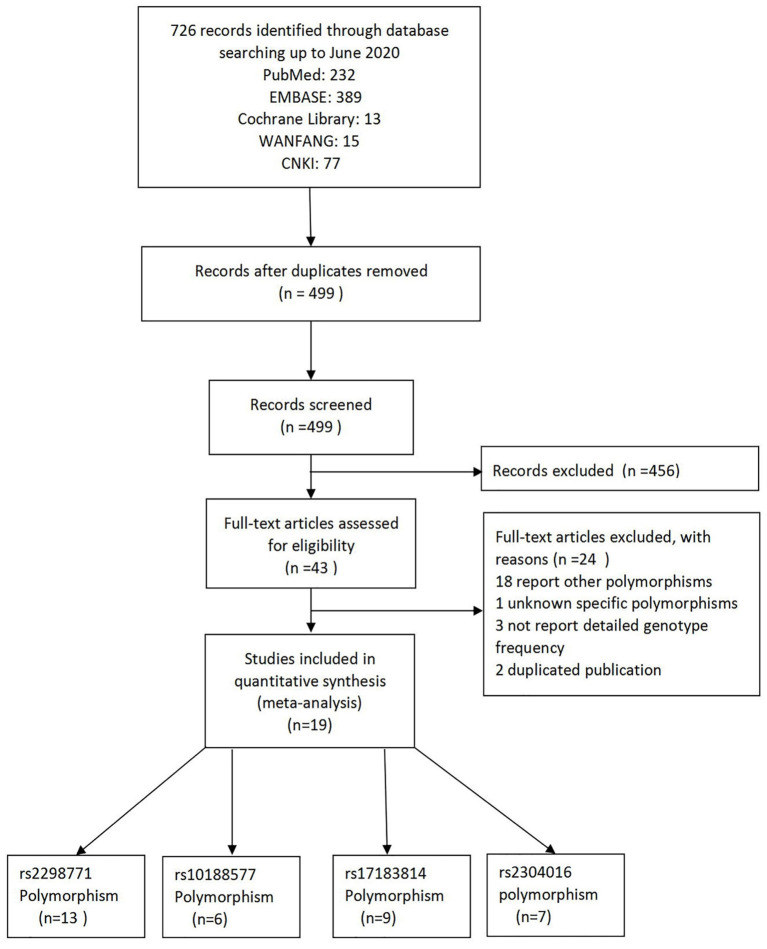
Flow diagram of literature screening.